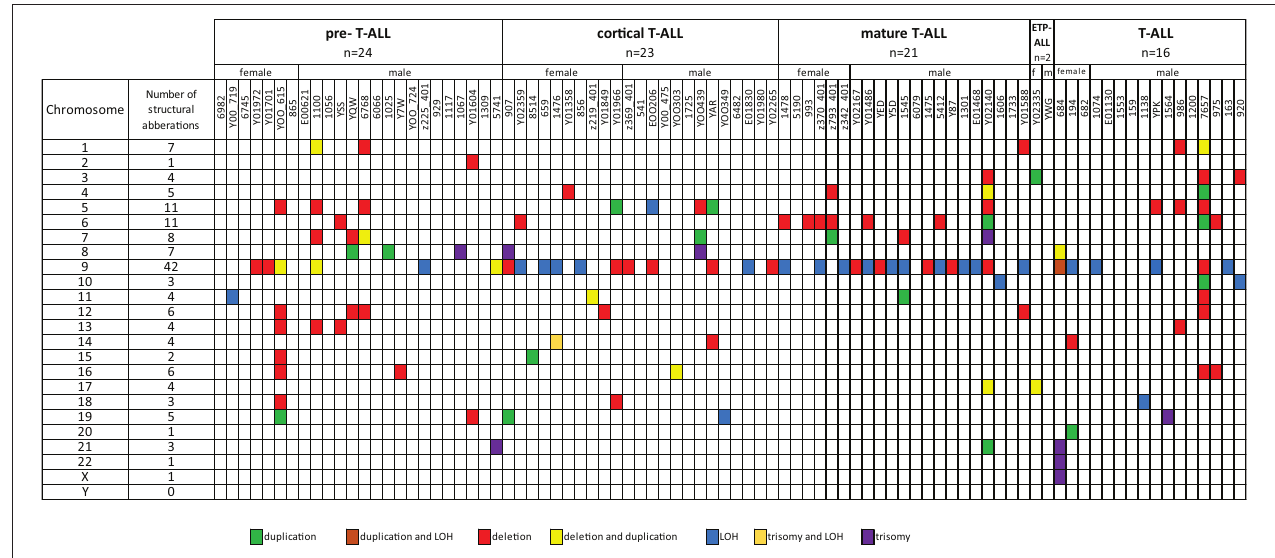
FIGURE 1 | Frequencies of structural chromosomal abnormalities in 86 T-ALL cases according to particular T-ALL subtypes.